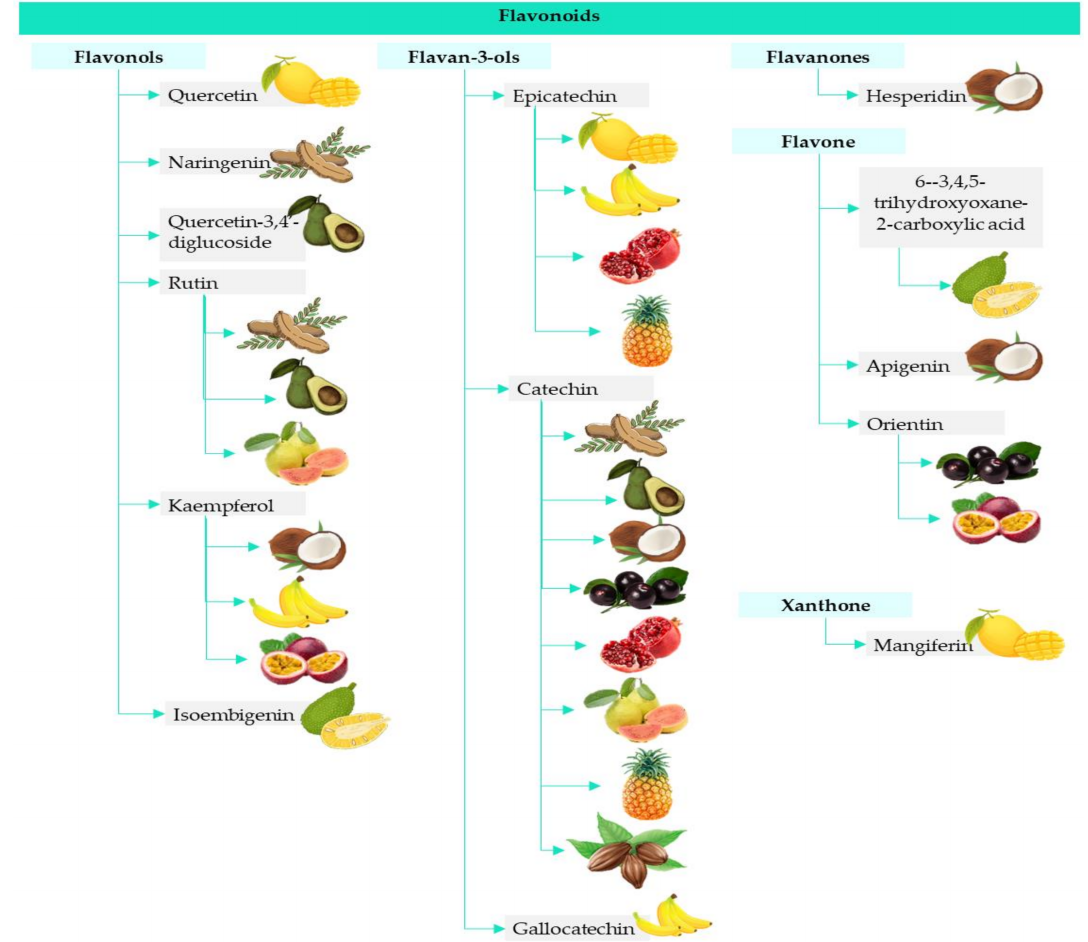
Figure 2. The main flavonoids found in tropical fruits